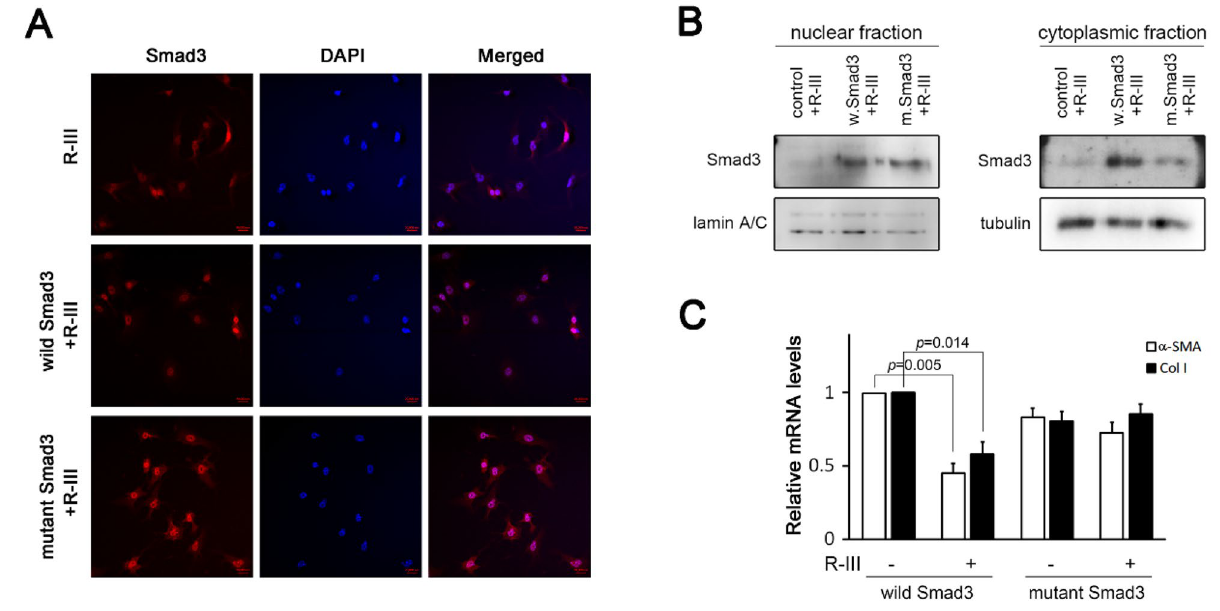
Figure 6. Smad3 linker phosphorylation affects its nuclear translocation in hepatic stellate cells. ( A – C ) Hepatic stellate cells after passage 1 (HSCs-P1) were transfected with empty vector or with an expression plasmid encoding wild-type or mutant Smad3 (S204A, S208A, S213A) and then treated with R-III (0.25 μM) for 20 h. ( A ) The treated cells were analyzed by immunofluorescence using anti-Smad3 antibody. ( B ) Nuclear and cytoplasmic fractions were prepared from the treated cells and subjected to western blotting using anti-Smad3 antibody. Full-length blots are presented in Supplementary Fig. S4. ( C ) HSCs-P1 were transfected with an expression plasmid encoding wild-type or mutant Smad3 and then treated with or without R-III. The α-SMA and collagen type I (col I) expression levels in the treated cells were analyzed by real-time PCR. P -value, paired t -test ( n = 3) (compared with untreated HSCs-P1).